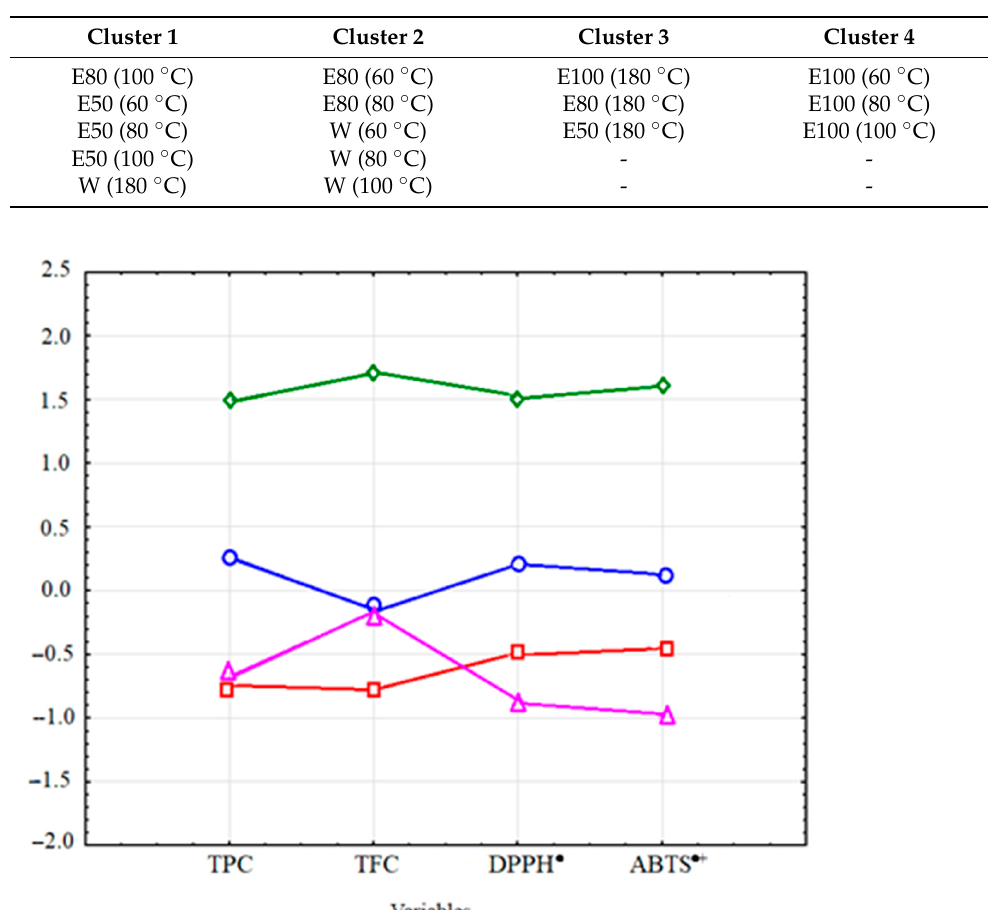
Table 3. Composition of clusters determined by cluster analysis (k-means method). Abbreviations: see Table 1.